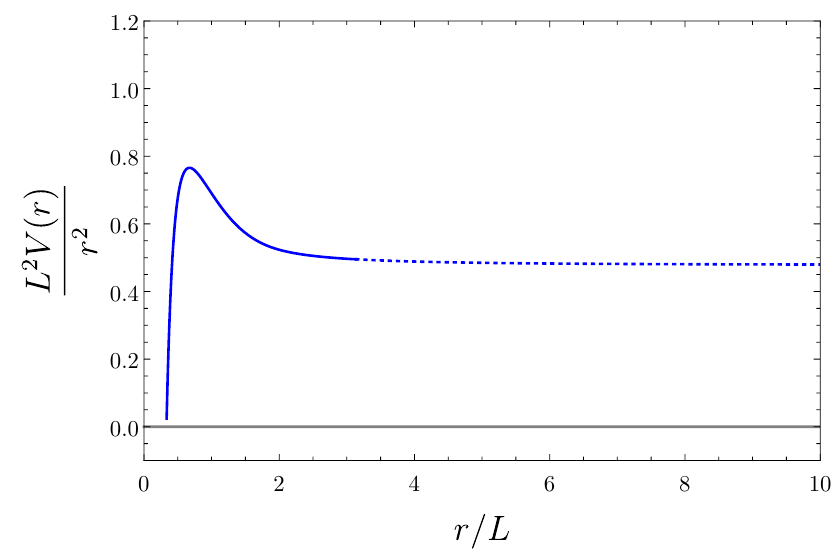
Figure 18 . An example of a numeric solution. Here the solid blue curve corresponds to the result of the numeric integration, while the dotted curve corresponds to the asymptotic expansion. The plot is for the case of NUT solutions in the quartic quasi-topological theory for B = CP 2 with (cid:16) = (cid:0) 10, n=L = 1 = 3, a 2 L 2 = 0 : 1181855186708097 and (cid:15) = 10 (cid:0) 2 L . A working precision of 40 was used in producing this